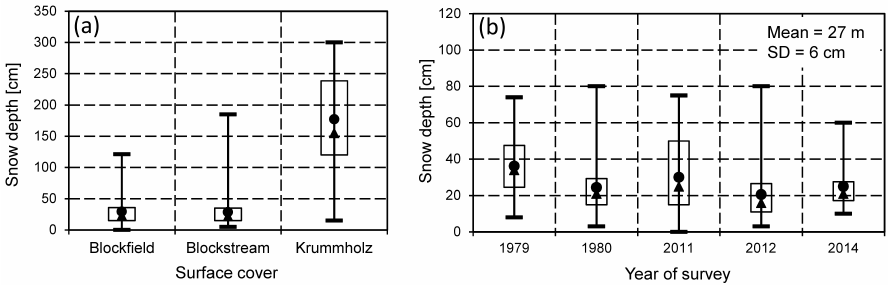
Figure 4. Box-and-whisker plots showing (a) the uneven snow thickness between the alpine tundra environment (blockfields and block- streams) and the krummholz belt and (b) the interannual variability of the snowpack thickness on the wind-swept summit. The “box” is delimited by the upper and the lower quartile; the median and the mean are represented by the triangle and the circle respectively. The “whiskers” represent the maximum and minimum snow height values. Table 4. Details of the snow’s physical and thermal properties measured and calculated for the nine snow pits made on Mont Jacques-Cartier (MJC) and Petit Mont Saint-Anne (PMSA). The snow density ( ρ s ) and the thermal conductivity ( λ) of each snowpack layers have been averaged for each snowpack. R represents the thermal resistance of the